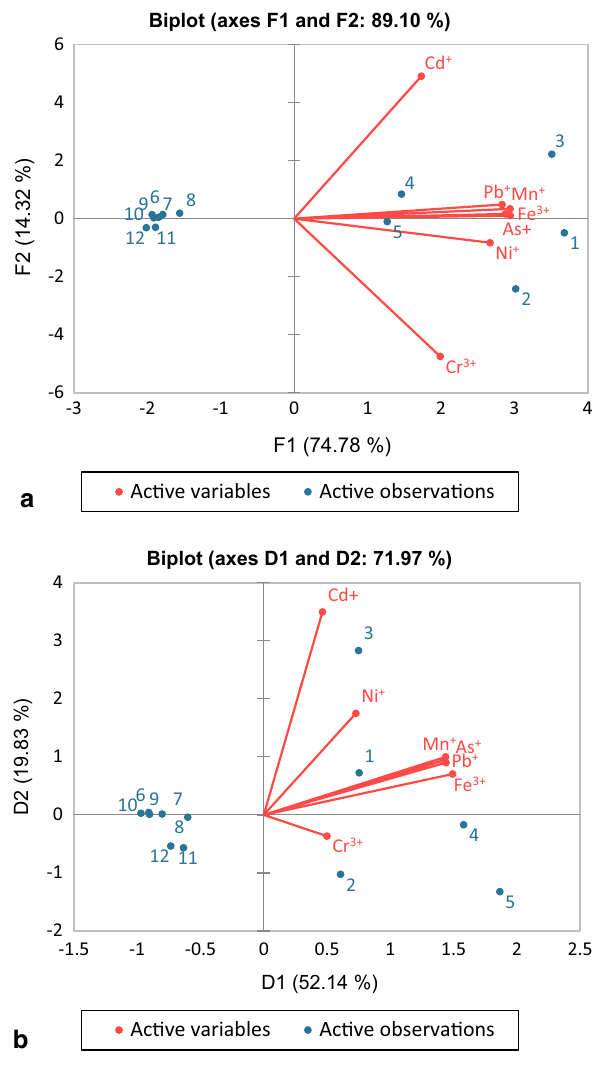
Fig. 12 Biplots of the components of tested water sources, before ( a ) and after Varimax rotation ( b )